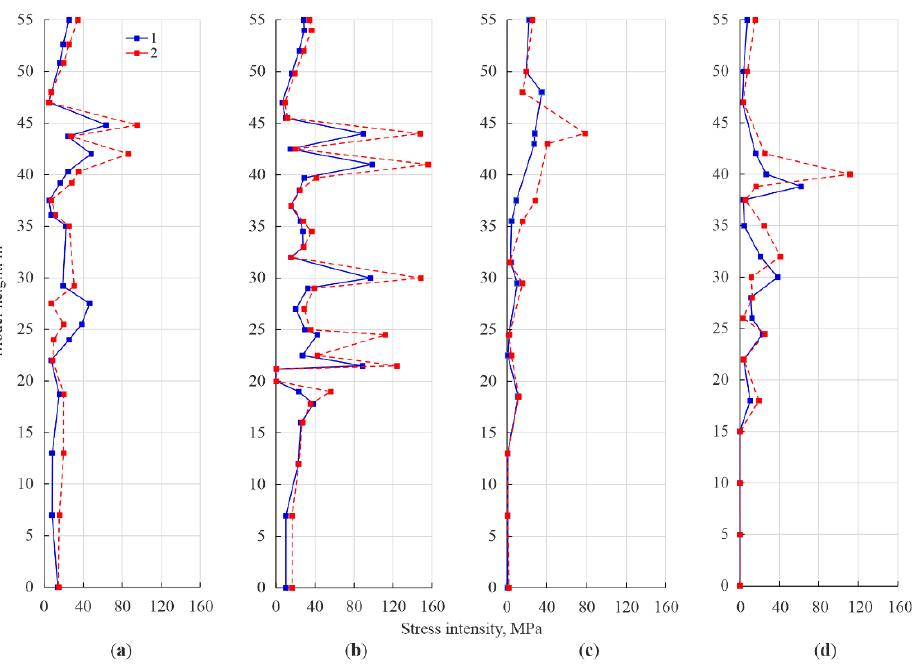
Figure 5. Changes in the stress intensity in the coal ‐ bearing mass sections at different distances from the face: ( а ) Section І (10 m ahead of the longwall face); ( b ) Section ІІ (directly within the zone of the longwall face); ( c ) Section ІІІ (10 m behind the longwall face); ( d ) Section IV (30 m behind the longwall face); 1—using selective technology with leaving the rocks in the mined ‐ out space ( m rp = 0.5); 2—using traditional technology with complete caving of the roof rocks.